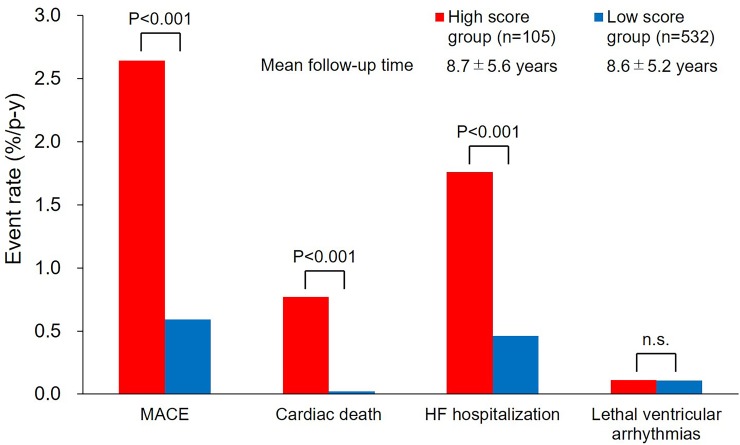
Comparison of event rate between the high and the low MELD-XI score groups.During the mean follow-up of 8.6±5.3 years, MACE was noted in 51 patients. The incidence rate of MACE, cardiac death, and HF hospitalization was significantly higher in the high score group compared with the low score group. In contrast, the incidence rate of lethal ventricular arrhythmias was comparable between the two groups. HF, heart failure; MACE, major adverse cardiac events; MELD-XI, model for end-stage liver disease excluding international normalized ratio; p-y, person-year.